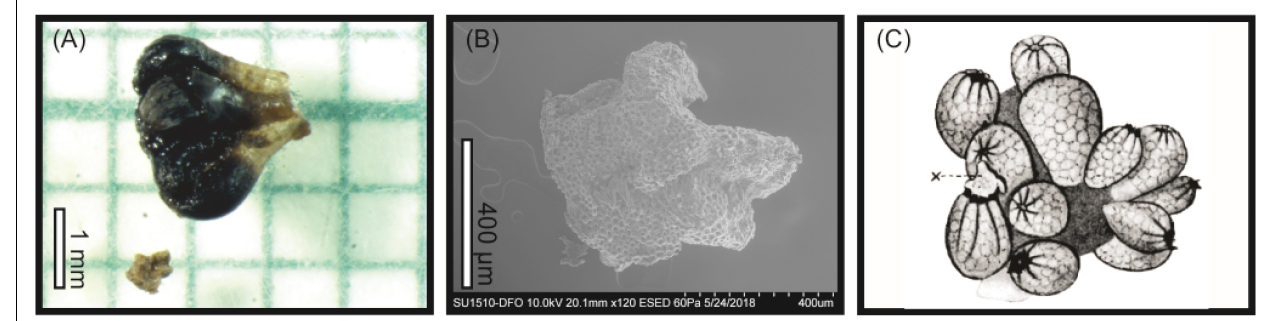
FIGURE 8 | (A) Piece of branch of Duva florida colony showing three large polyps and juvenile ophiuroid found within one of the polyps, (B) Scanning Electronic Microscopy (SEM) of the ophiuroid specimen seen in (A) , (C) reproduction of Fedotov (1924)’s sketch of a juvenile basket star leaving the polyp of a live Drifa glomerata (published as G. glomerata ) colony in Russia.